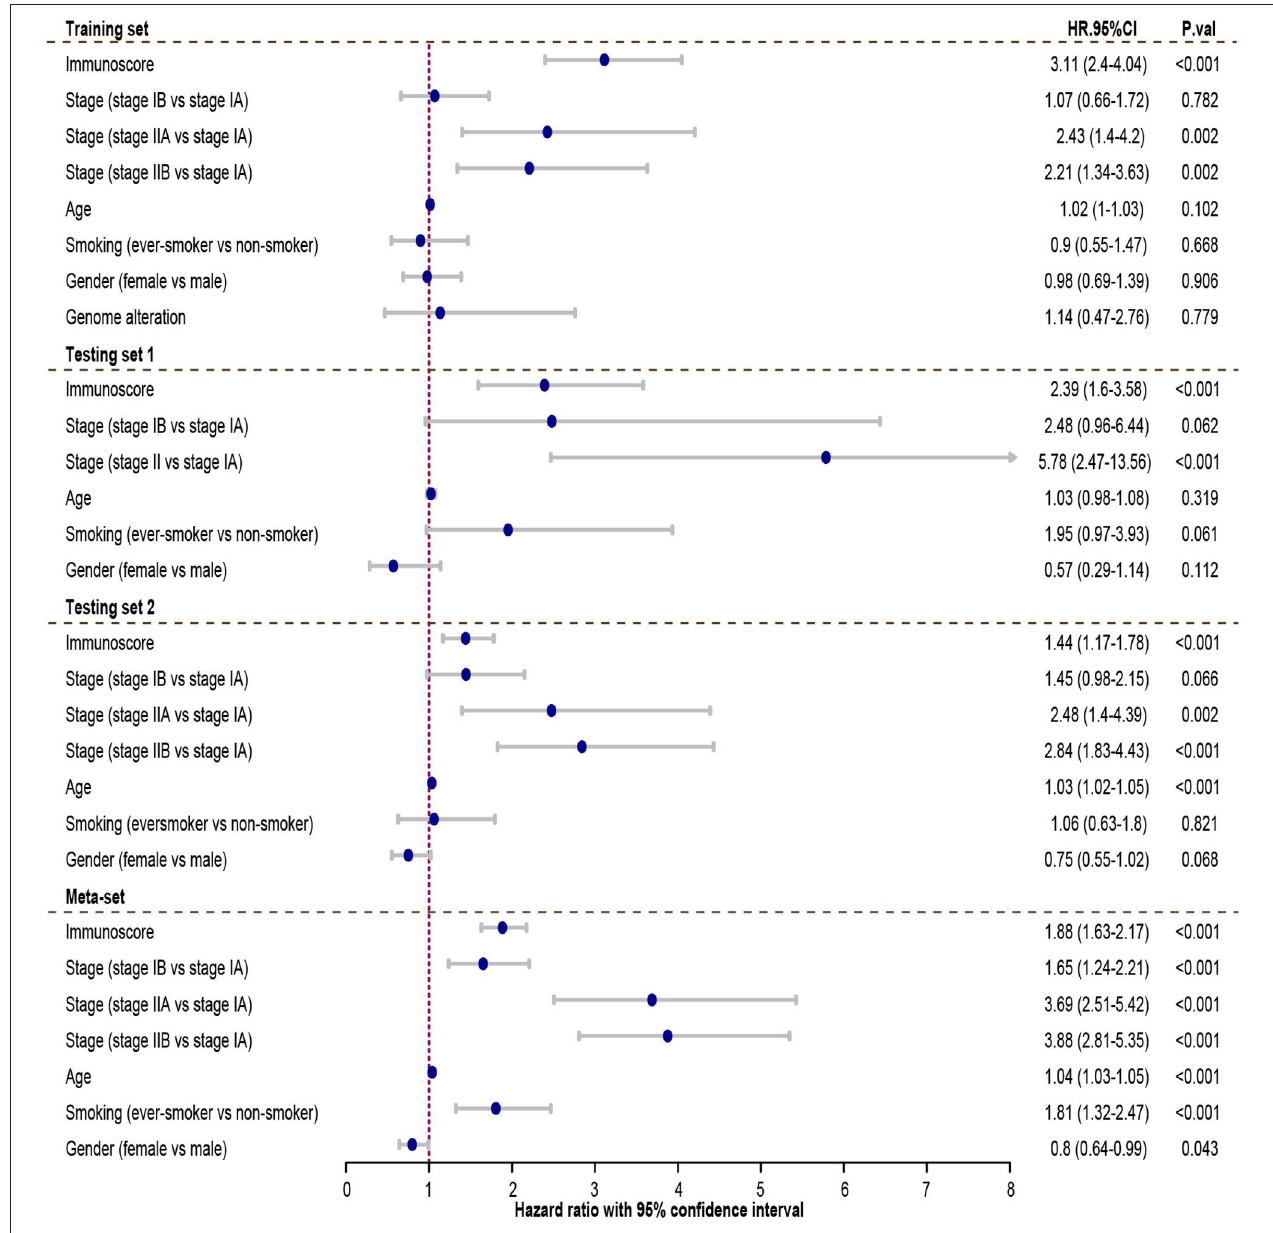
FIGURE 4 | The univariate Cox analysis of the immunoscore and clinicopathological factors. The HR in training cohort was 3.11, with 95% confidence interval (CI) from 2.44 to 4.04 ( P < 0.001). The HR in testing set 1 was 2.39, with 95% CI from 1.6 to 3.58 ( P < 0.001). The HR in testing set 2 was 1.44, with 95% CI from 1.17 to 1.78 ( P < 0.001). The HR in meta-set was 1.88, with 95% CI from 1.63 to 2.17 ( P < 0.001). HR.95%CI, hazard ratio with 95% confidence interval.